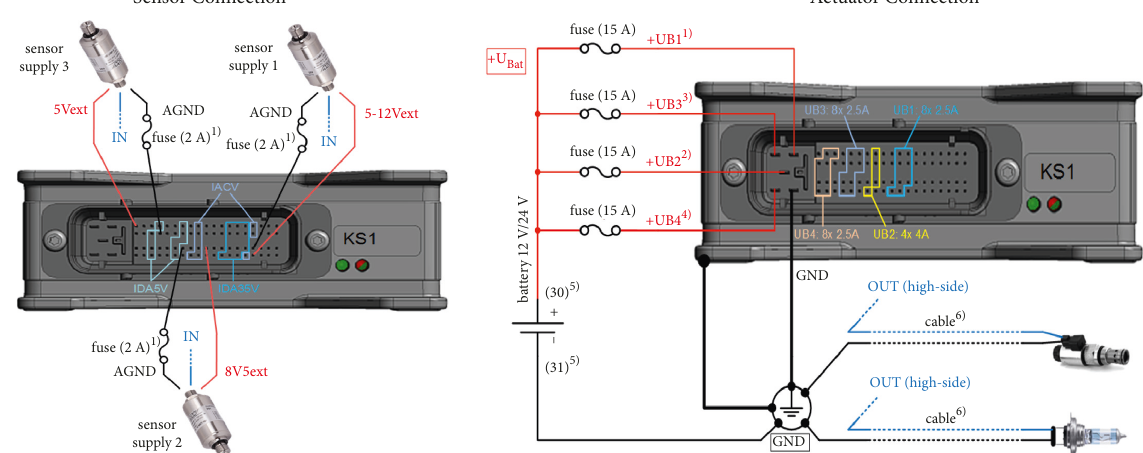
Figure 8: Wiring diagram of sensor and electric proportional valve